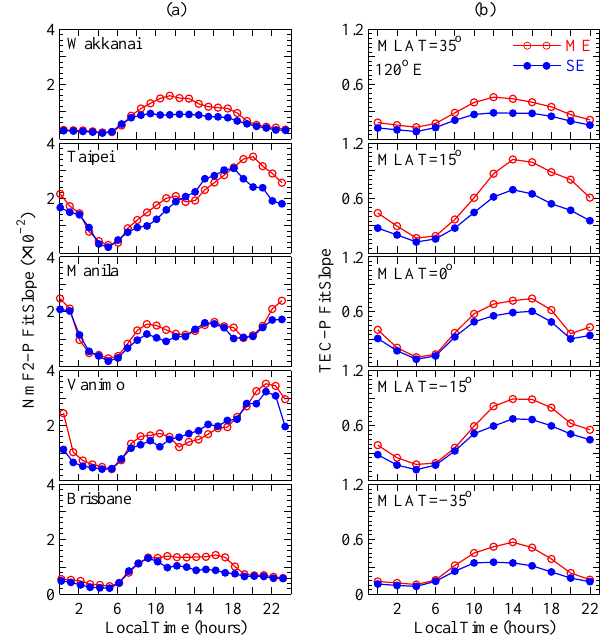
Fig. 7. Local time variations of the linear fit slopes of (a) Nm F2 and (b) TEC with the P index (fitting for P < 140, see Fig.